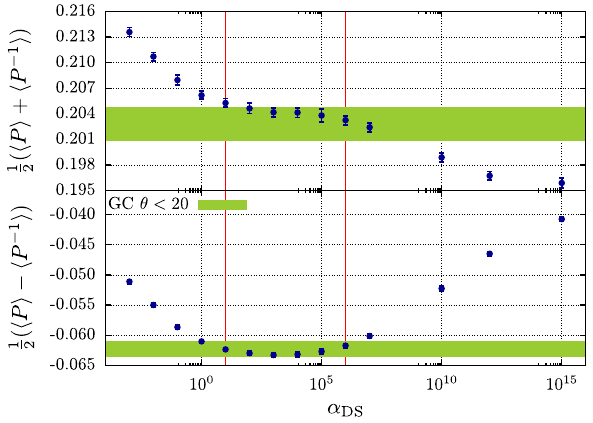
Fig. 5 The average Polyakov loop as function of α DS at N τ = 20 and μ = 2 . 45. Also shown, in green bands, are results from simulations with gauge cooling. The vertical red lines indicate the region where there is agreement between GC and DS